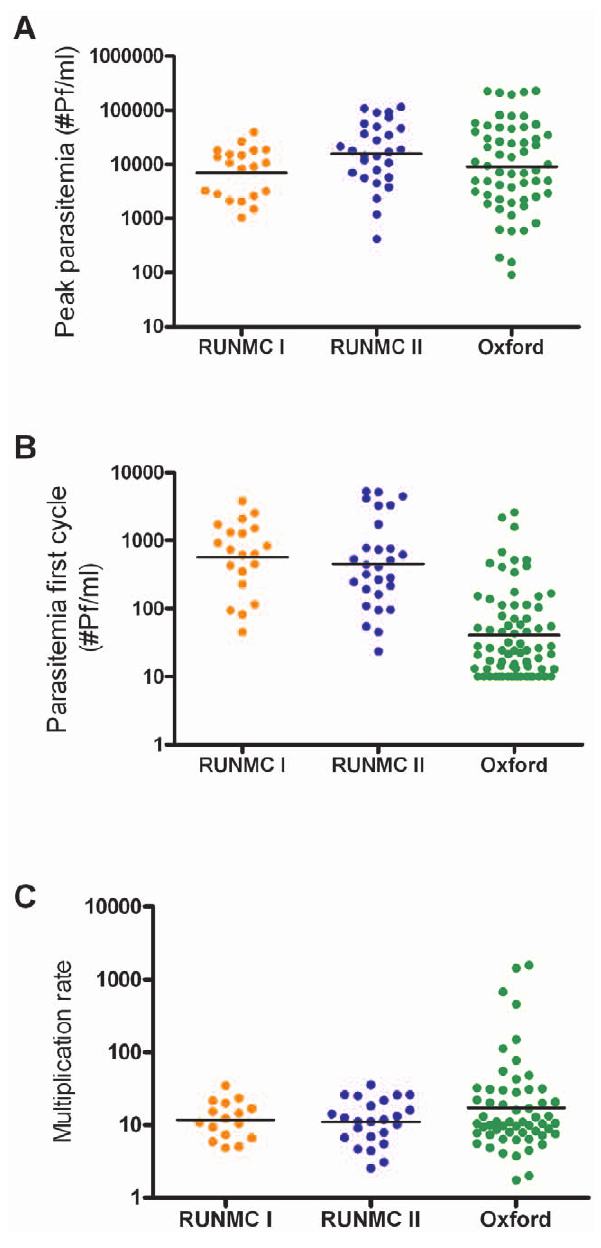
Figure 3. Statistics of Q-PCR parasitemia per cohort. Peak parasitemia (A, one-way ANOVA p=0.13), geometric mean parasitemia during the first blood stage parasite multiplication cycle, day 6.5 to 8.5 (B, one-way ANOVA p , 0.001) and blood stage multiplication factor (C, one-way ANOVA p=0.97) per cohort. Individual data is plotted, lines represent geometric means. The threshold of detection of parasites by Q-PCR was 20 parasites/ml blood. Any CT value . 45 was assigned a parasitemia of 10 parasites/ml.